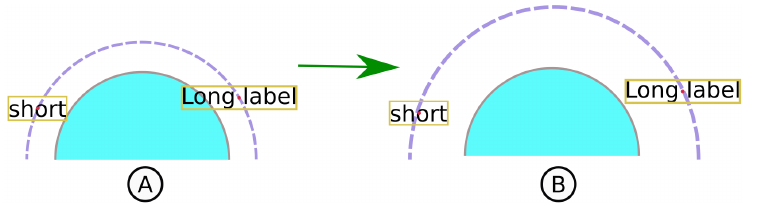
Figure 6. Traditional linear layouts. ( A ) Display of labels of varying sizes may cause overlapping between the label and the real circle. ( B ) The problem is resolved after increasing the radius of the virtual circle.